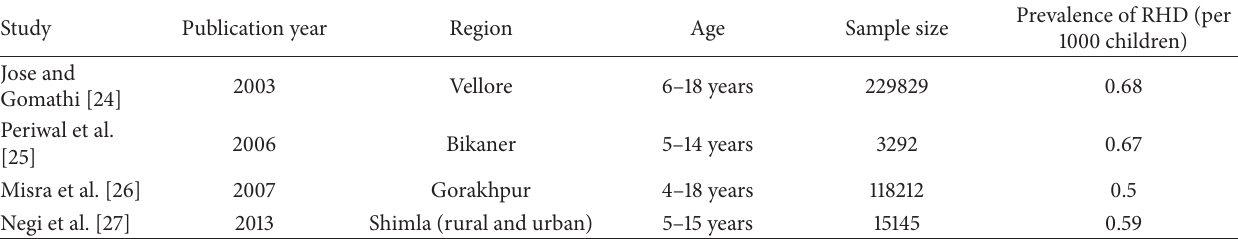
Table 4: Epidemiological studies of rheumatic heart disease in school children of different regions of